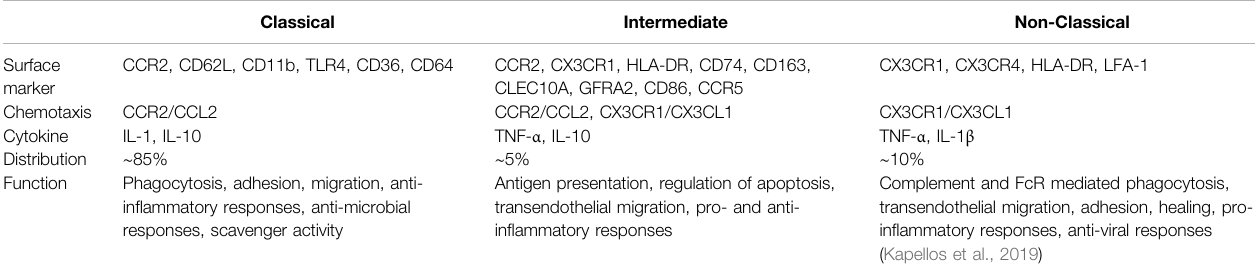
TABLE 1 | Characterization of monocyte